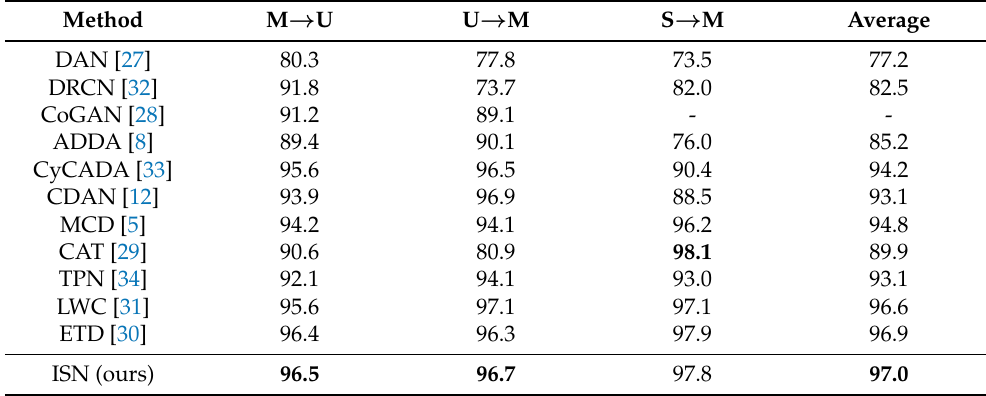
Table 2. Accuracy (%) on Digits